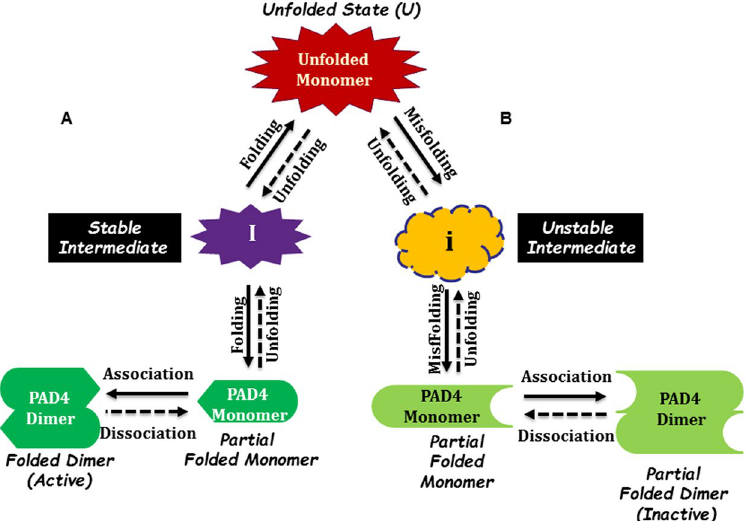
Figure 6. Proposed model of the PAD4 folding pathway. ( A ) Three-state folding pathway with the formation of a stable intermediate and assembly of dimers of the PAD4 WT, PAD4_Ca1, PAD4_Ca2 and PAD4_Ca5 mutant enzymes. ( B ) Two-state folding pathway with the formation of an unstable intermediate and assembly of dimers of PAD4_Ca3 and PAD4_Ca4 mutant